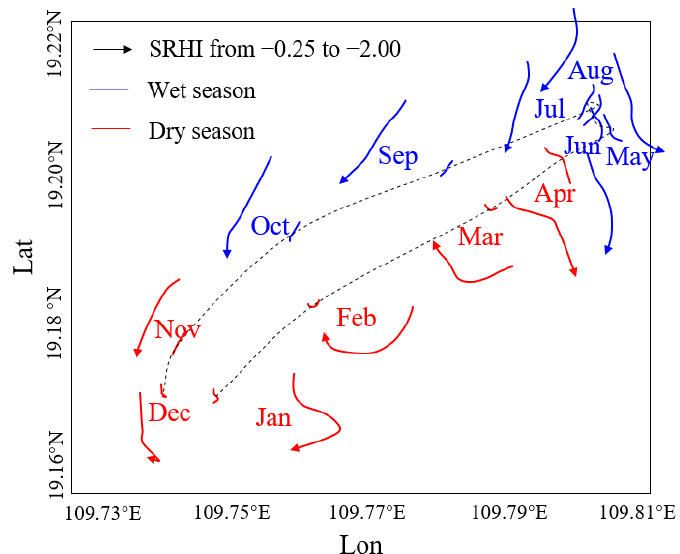
Figure 5. Spatial pattern changing tracks of rubber plantations’ GPP vulnerability with drought intensities and drought occurrence month over Hainan Island. Arrow represents the changing tracks of rubber plantations’ GPP vulnerability with SRHI from − 0.25 to − 2.00; Red means the dry season, and blue means the wet season. The extreme and light STFDs occurring in April and September were chosen as ex- ample scenarios to analyze the spatial pattern of the vulnerability of rubber ecosystem GPP to STFD, since they are the months when STFD occurred and GPP loss was the great- est or least in terms of the overall numerical performance. The overall pattern (Figure 6) showed that rubber plantations in Northern Hainan Island are more vulnerable to STFD than in the southern part; rubber plantations in Western Hainan Island are more vulner- able to STFD than in the ea stern part. The spatial distribution of rubber plantations’ GPP losses caused by STFDs of the same intensity occurring in different months was not con- sistent. The extreme drought in April had the most significant and spatially contiguous effect on the GPP of rubber plantations in northwestern Hainan Island; the drought of the same intensity that occurred in September had a more obvious effect on the GPP of rubber plantations in the northern part than in other parts of Hainan Island. The effect of the light drought in April on the GPP of rubber plantations in Hainan Island showed a decreasing pattern from northwest to southeast, while the vulnerability of rubber ecosystem GPP to a drought of the same intensity as the one from April but occurring in September had the distribution characteristics of increased vulnerability from northeast to southwest. The effect of STFD in April on the GPP of the rubber ecosystem was more concentrated in spatial pattern than the drought in September. The GPP losses caused by the light drought in April and the extreme drought in Sep- tember at rubber plantations in Hainan Island were relatively close in value (0.32 gC/m 2 /day light STFD in April vs. 0.36 gC/m 2 /day extreme STFD in September), but the spatial distribution of GPP loss behaved differently (Figure 6). The rubber ecosystem GPP in the northern part, especially the northwestern part, of Hainan Island showed relatively high vulnerability to the light drought in April, while the extreme drought that occurred